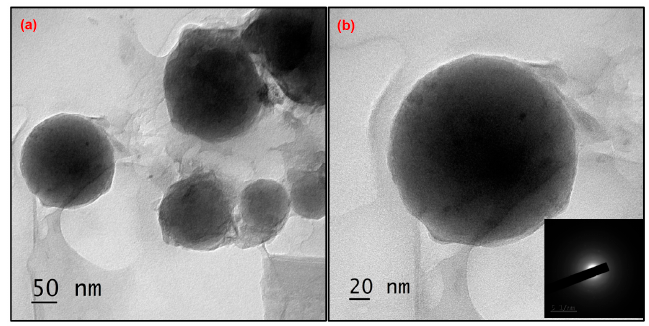
Figure 4. ( a , b ) High-resolution transmission electron microscopy (HRTEM) image of the Co 3 (PO 4 ) 2 nanosphere sample calcined at 300 °C.